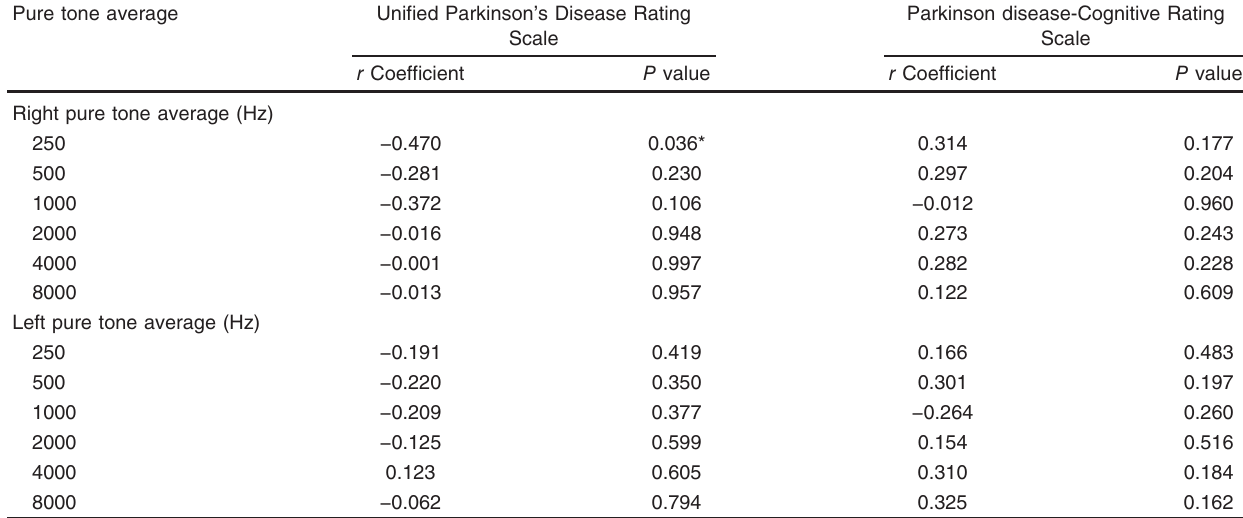
Table 5 Correlation between pure tone average thresholds and Unified Parkinson ’ s Disease Rating Scale and Parkinson disease- Cognitive Rating Scale in patients with Parkinson disease Pure tone